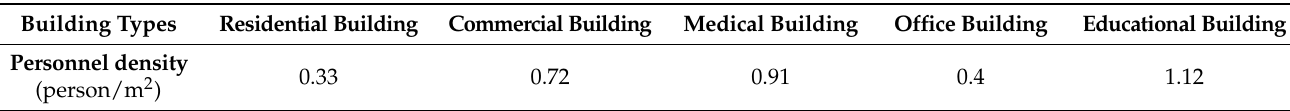
Table 6. Personnel